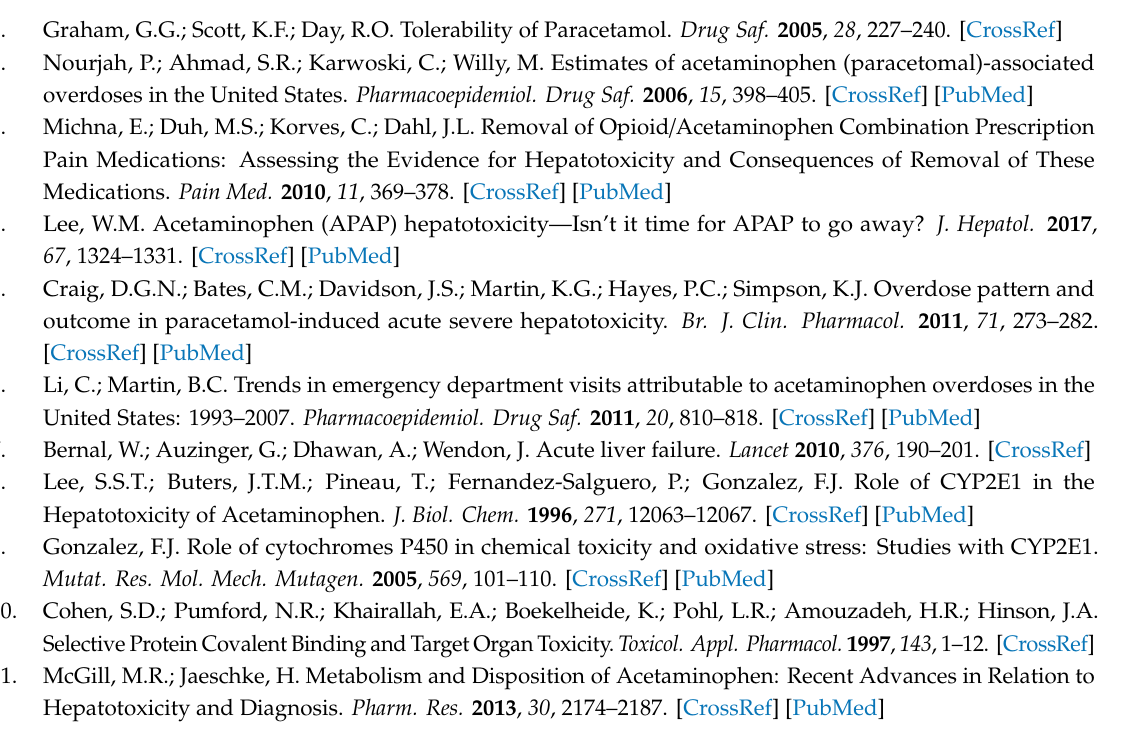
Figure S1. Quantification of CHOP positive cells in immunohistological images. Figure S2. CHOP induction in APAP liver injury and the e ff ect of a JNK inhibitor. Figure S3. Mito-T reduces APAP-induced mitochondrial oxidative stress in mouse livers. Figure S4. Pathophysiology of APAP-induced liver